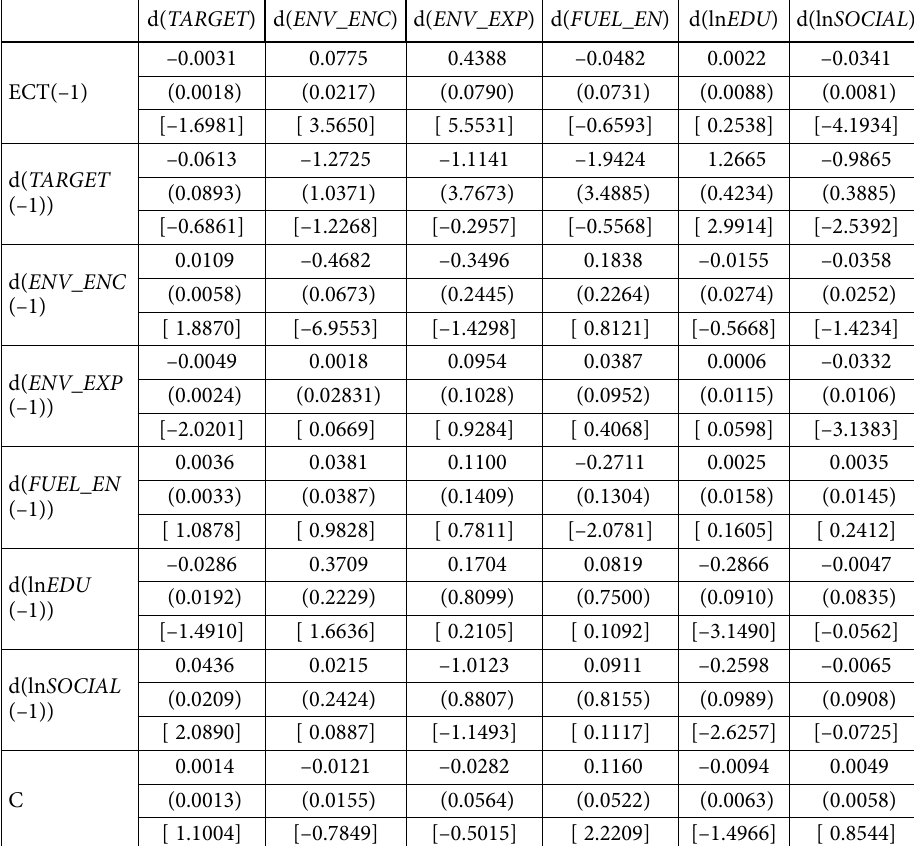
Table 11. VECM estimation (source: author’s own